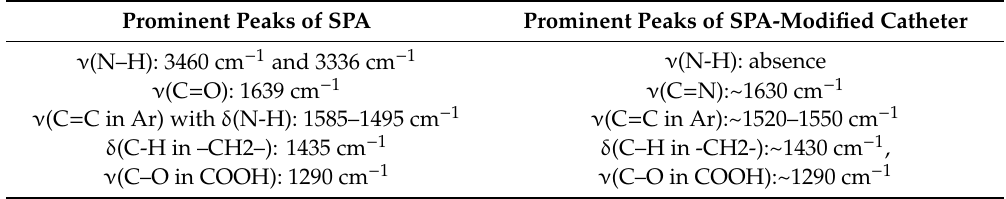
Table 1. Summary of FTIR analysis of the SPA-modified catheter following SPA-M1 method. Table 1 . Summary of FTIR analysis of the SPA-modified catheter following SPA-M1 method . Prominent Peaks of SPA Prominent Peaks of SPA-Modified Prominent Peaks of SPA Prominent Peaks of SPA-Modified Catheter